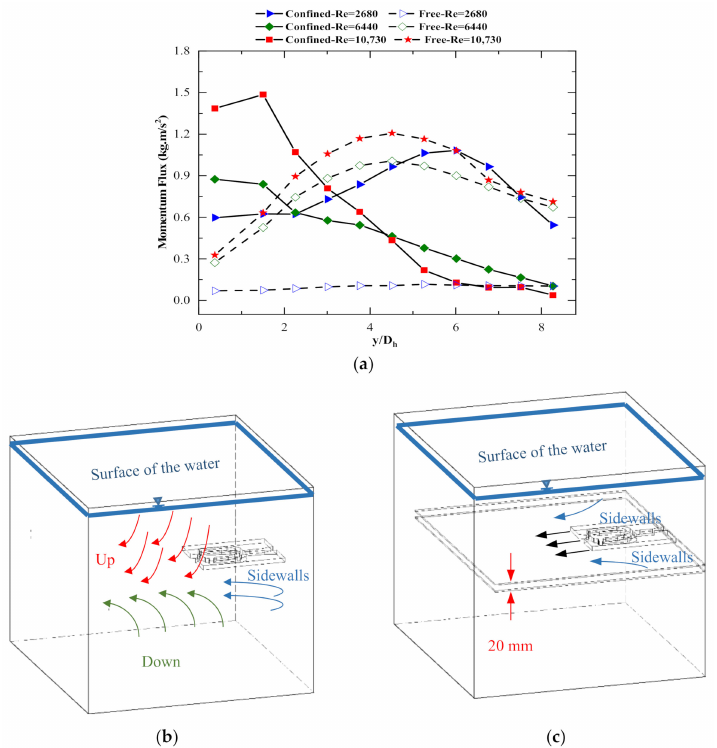
Figure 12. ( a ) Momentum flux for both the free and fully confined domains at di ff erent Reynolds number, entrainment of fluid for ( b ) free and ( c ) fully confined external